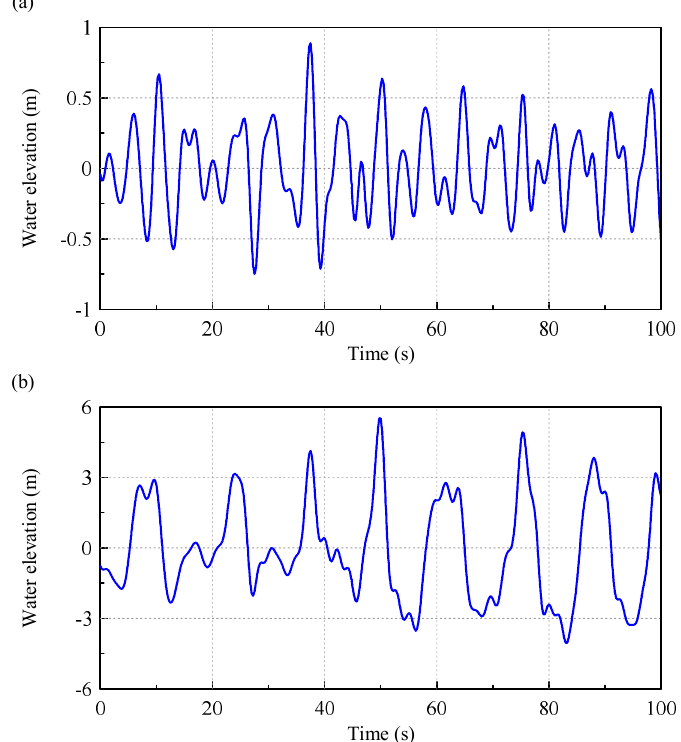
Figure 15. ( a ) Normal wave condition, H s = 1.4 m, T p = 6.1 s; ( b ) 50-year extreme wave condition, H s = 8.24 m, T p = 12.01 s.